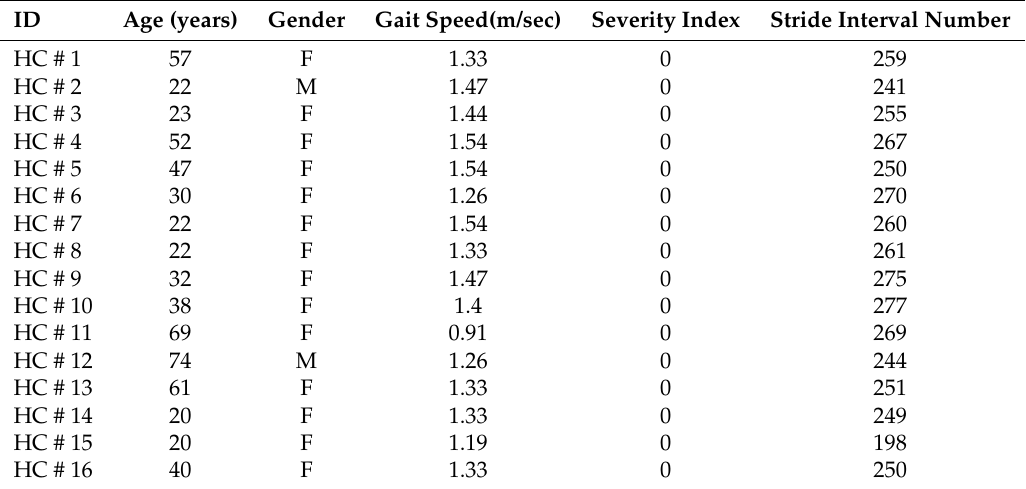
Figure 6. An illustration for the gait dynamics time series [11]. Table 1. The subjects’ clinical information and interval number of the healthy control (HC) group.